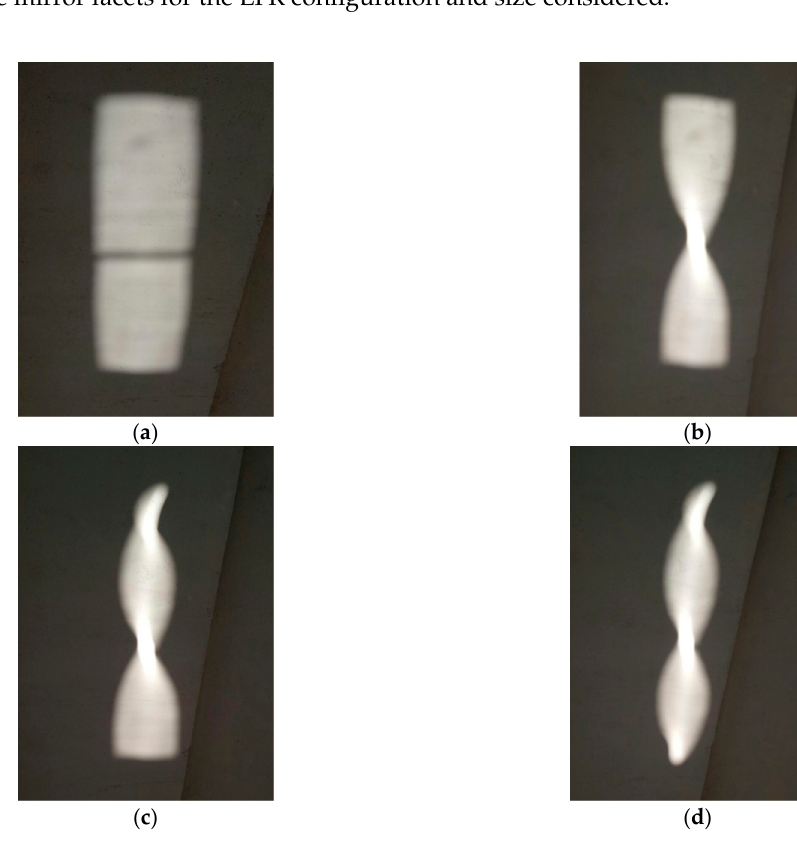
Figure 9. Reflected image for the assembly of naked mirror over shaped ribs facet configuration. ( a ) Non ribs clamped; ( b ) Middle ribs clamped; ( c ) Middle and one external ribs clamped; ( d ) Middle and both external ribs clamped.